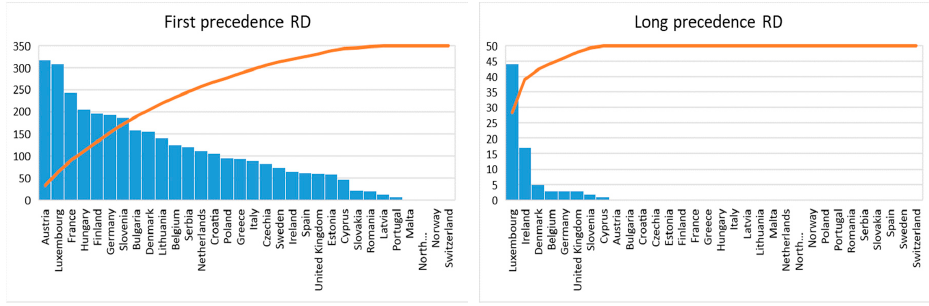
Figure 20. Number of precedence by country, first and long precedencies group RD.